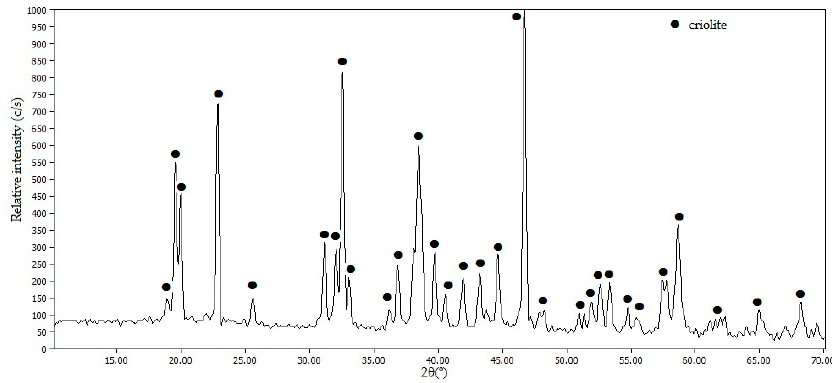
Figure 8. XRD pattern of the precipitated Na 3 AlF 6 .